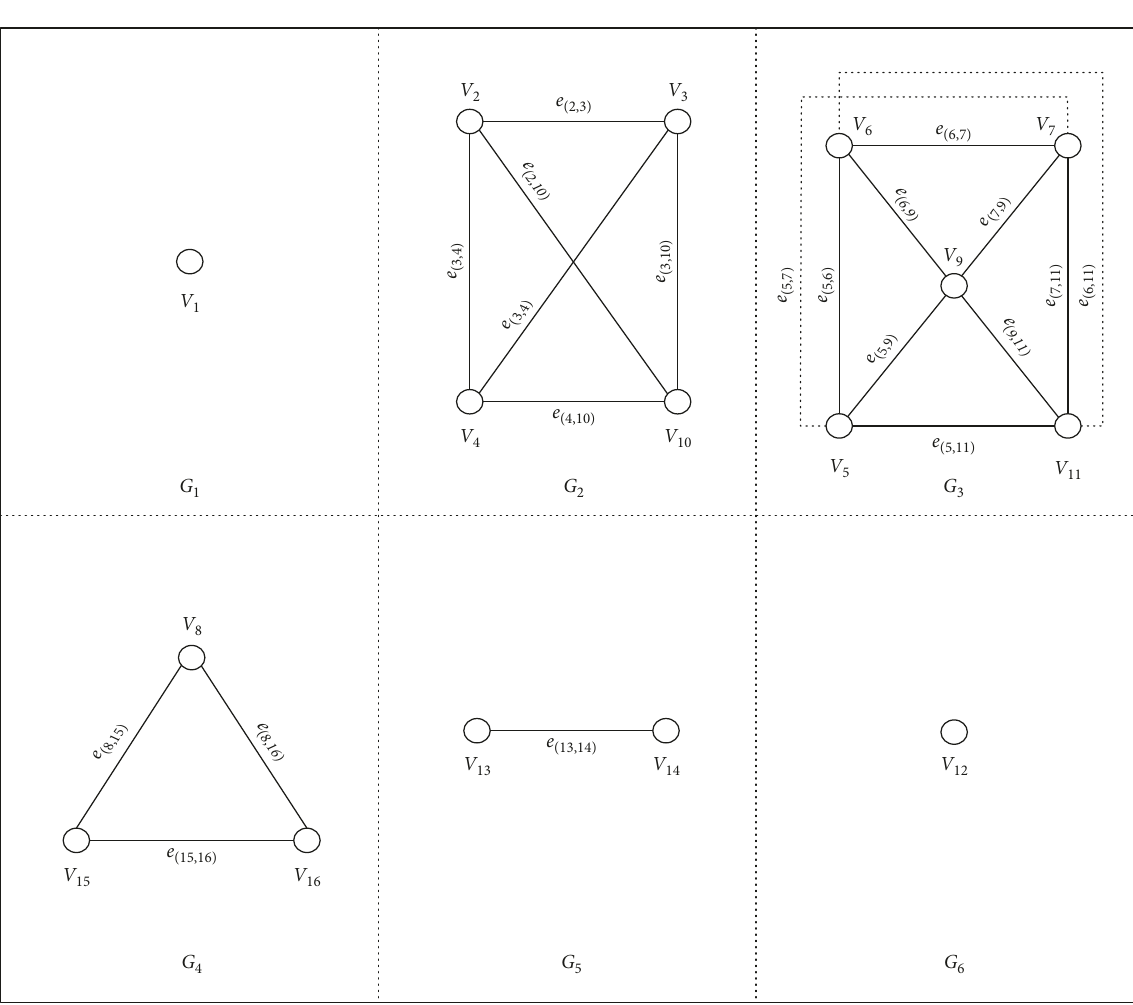
Table 4: The results of the index classification. Category Representative element